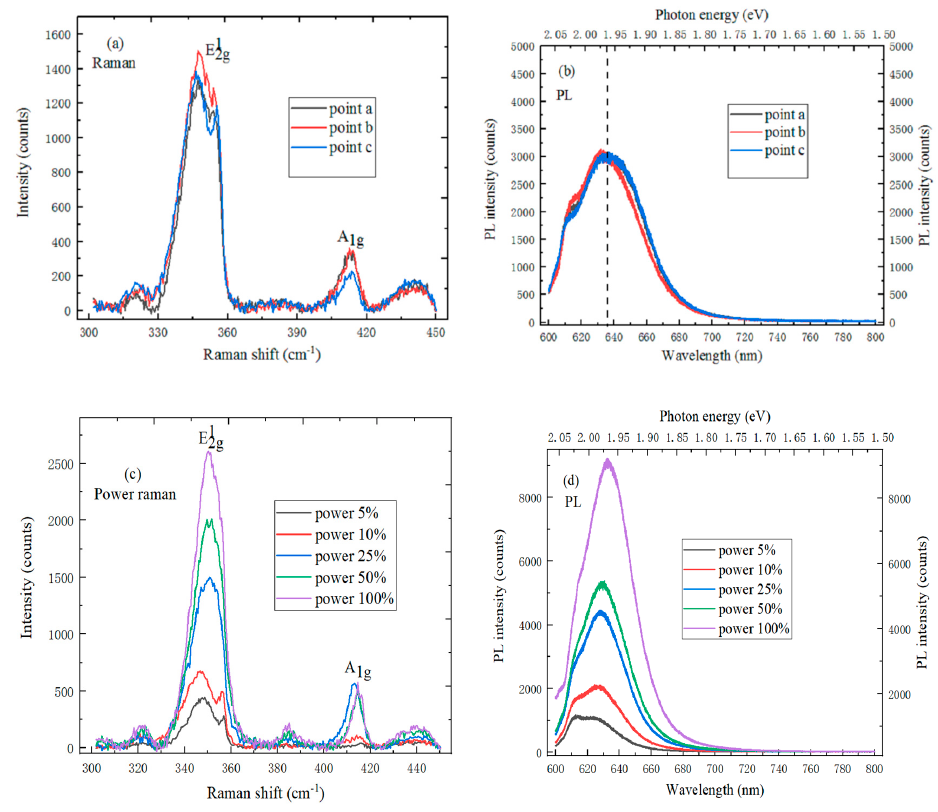
Figure 5. ( a ) The Raman spectrum and ( b ) Photoluminescence spectrum of monolayer WS 2 on SiO 2 /Si substrate at three different points; ( c ) Raman spectrum and ( d ) Photoluminescence spectrum of monolayer WS 2 on SiO 2 /Si Substrate under different laser powers.